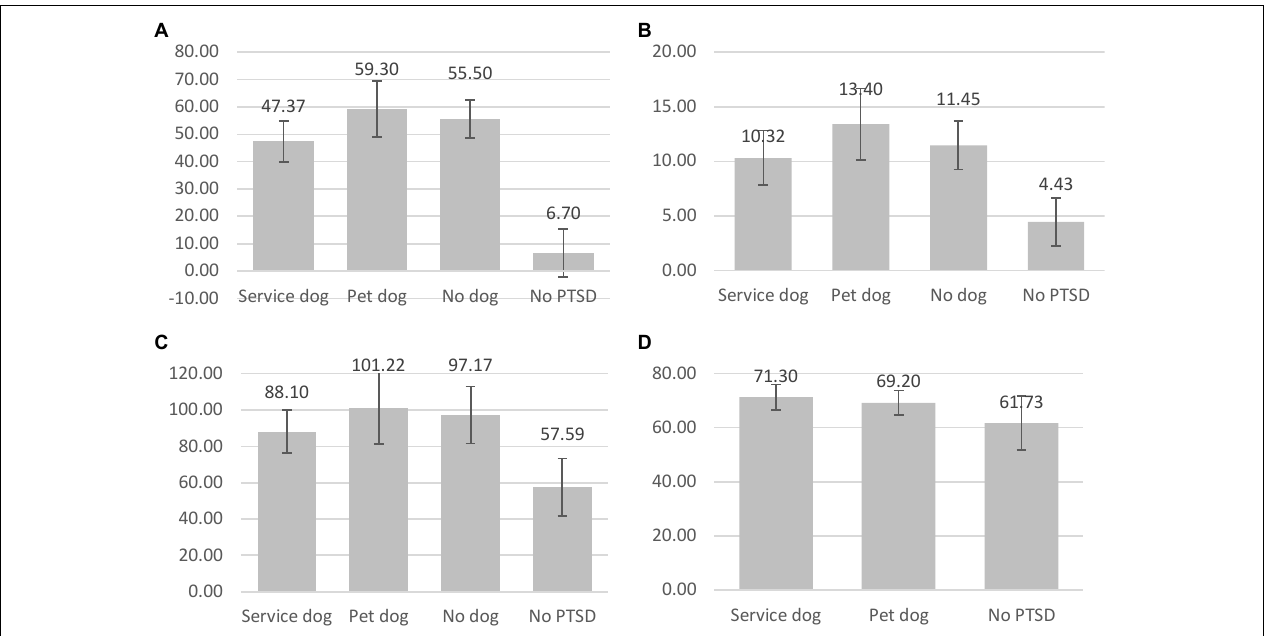
FIGURE 3 | The average scores for the PCL5 (A) , PSQI (B) , SF36 (C) , and MDORS (D) questionnaires per participant group. The four groups are: individuals with PTSD and a service dog ( n = 19, 13, 20, 20), individuals with PTSD and a companion dog ( n = 10, 9, 9, 10), individuals with PTSD without a dog ( n = 11, 12, 12), Individuals without PTSD ( n =